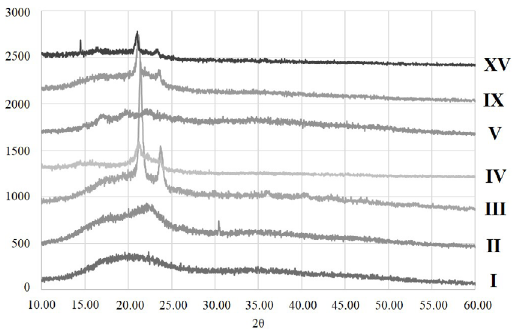
Figure 2. X-ray diffractograms for some selected biocomposites.